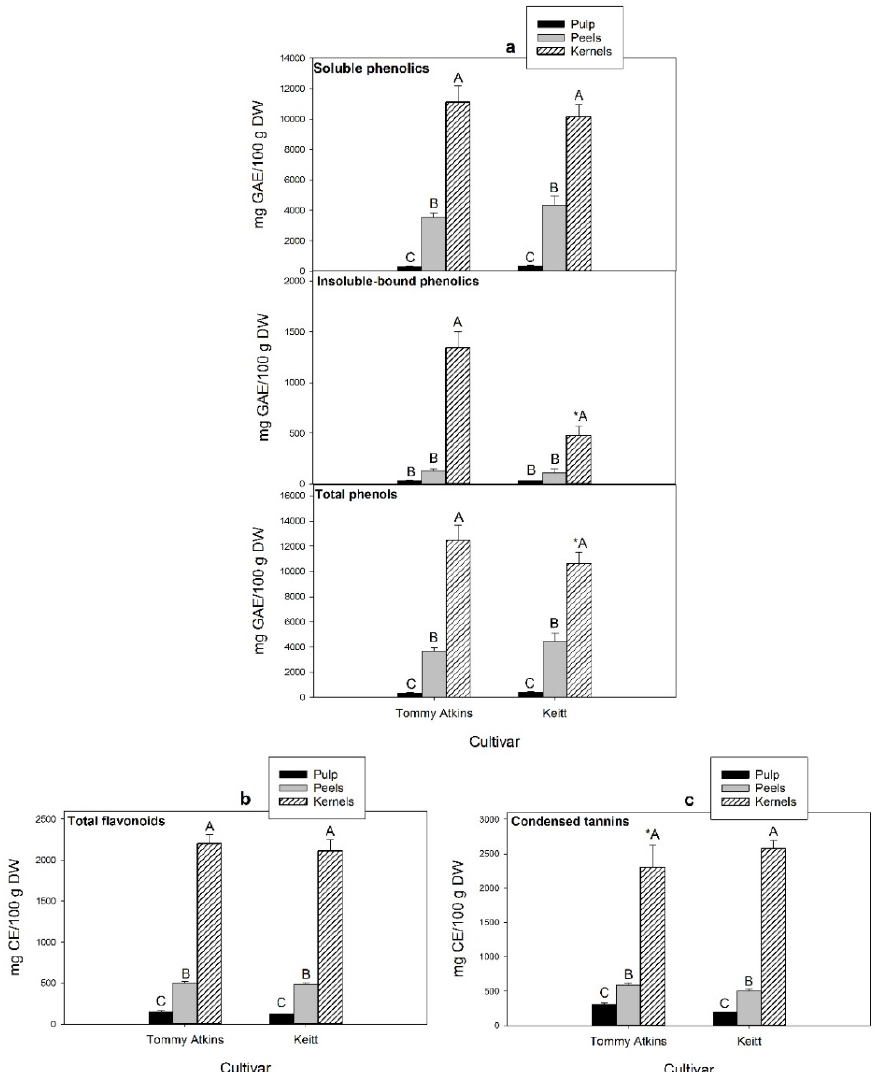
Figure 3. Contents of ( a ) soluble, insoluble-bounds and total phenolics; ( b ) total flavonoids and ( c ) condensed tannins in the pulp, peels and kernels of mango fruits (cvs Tommy Atkins and Keitt). Data, expressed as mg gallic acid equivalents (GAE)/100 g dw or mg catechin equivalents (CE)/100 g dw, are the mean ± standard deviation of five independent replicates ( n = 5). Data were submitted to one-way analysis of variance (ANOVA), differences among groups were detected using multiple comparison procedures (Tukey post hoc test, p < 0.05). For each trait, significant differences between cultivars within each fruit fraction were highlighted by an asterisk ( * ), different capital letters indicate differences among different fraction for the same cultivar ( p < 0.05).